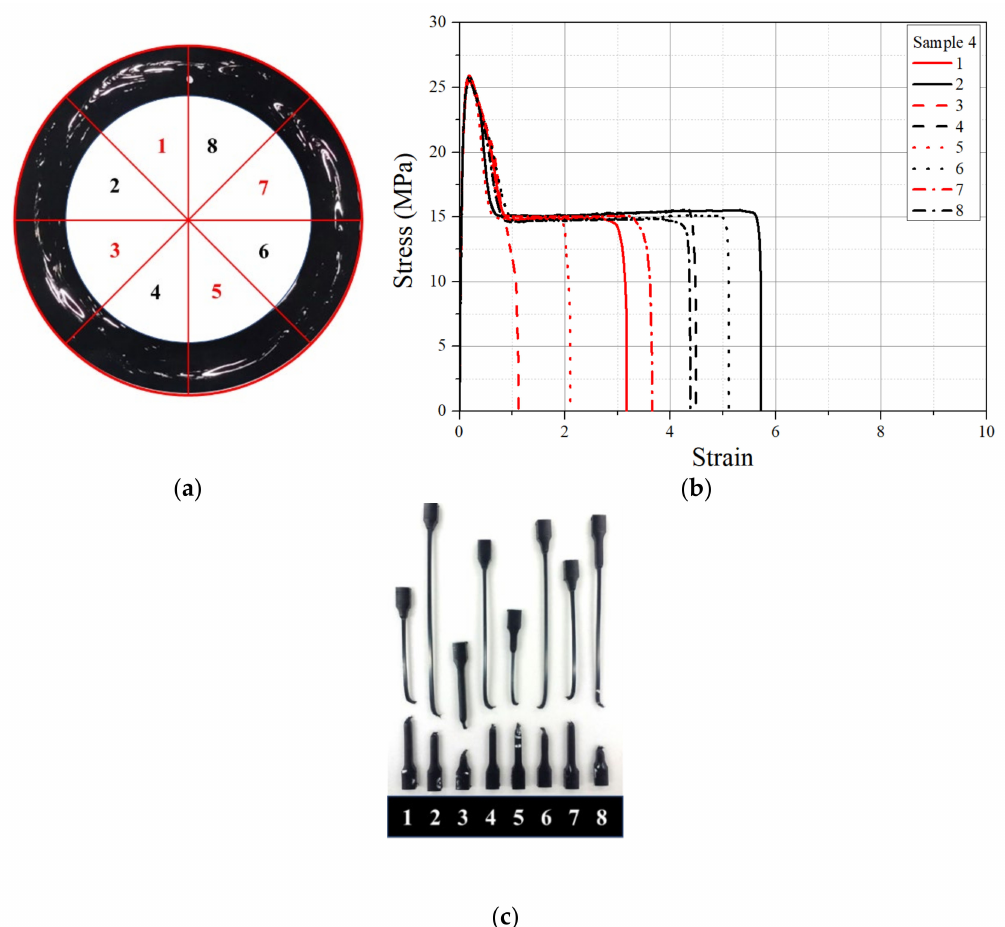
Figure 13. The 12 mm thick tensile specimens from pipe sample 4. ( a ) Eight sector locations, ( b ) tensile stress–strain curve of each specimen, and ( c ) tested